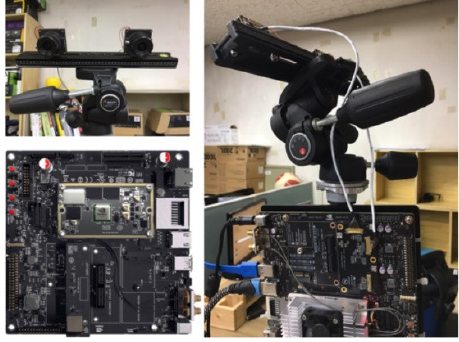
Figure 3. Stereo camera configuration of the proposed method.